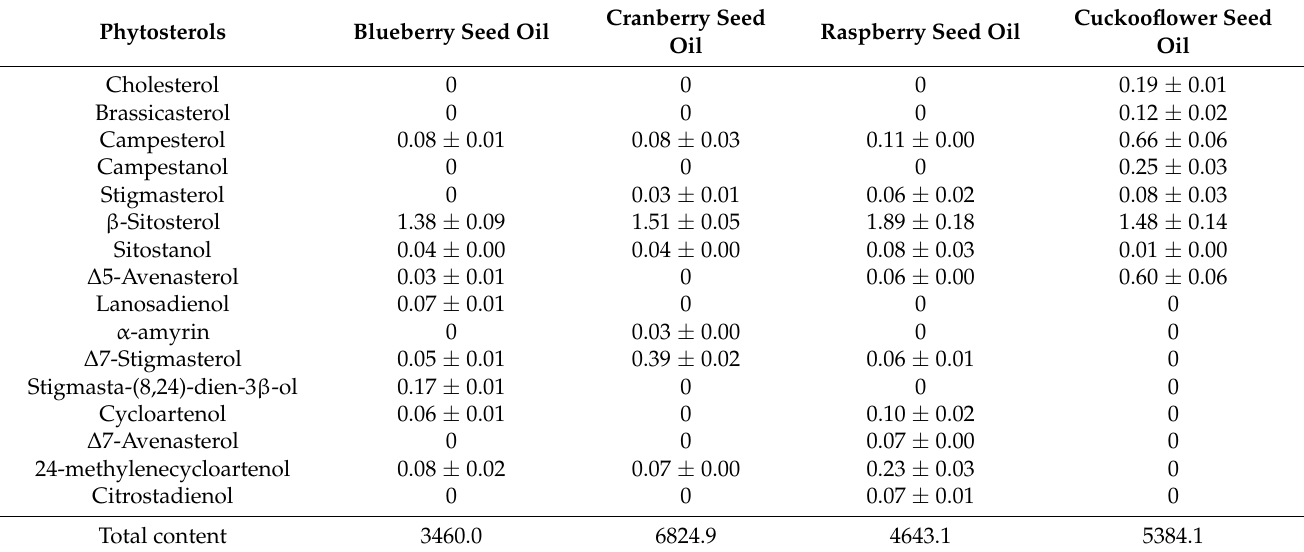
Table 3. Sterols content of oils from of blueberry, cranberry, raspberry and cuckooflower seed oils obtained by sonification (mg/g).